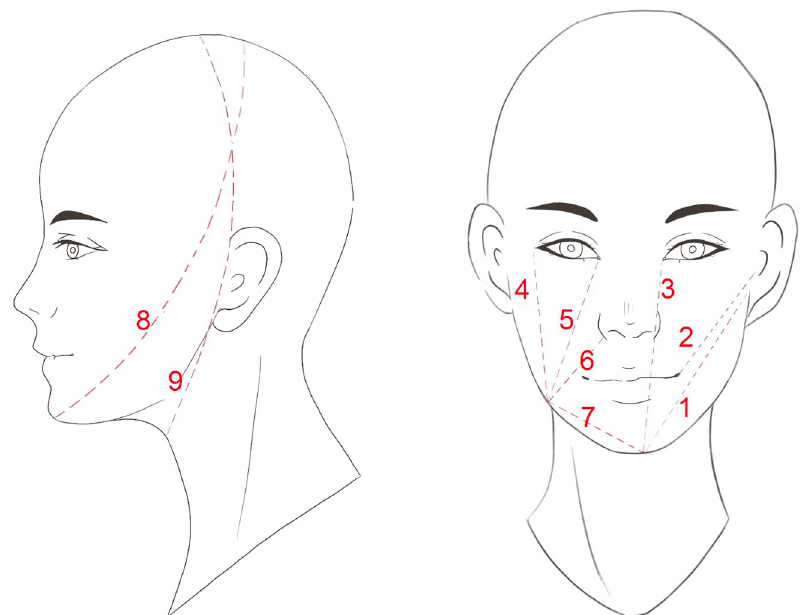
Fig 1. The tape placement lines. (1) Tragus to mental protuberance, (2) tragus to mouth angle, (3) mental protuberance to internal eye corner, (4) mandibular angle to external eye corner, (5) mandibular angle to internal eye corner, (6) mandibular angle to nasal wing, (7) mandibular angle to mental protuberance, (8) diagonal facial circumference—chin to crown of the head, and (9) vertical facial circumference—in front of the ear. The lines used for measuring the neck circumferences are not shown in this